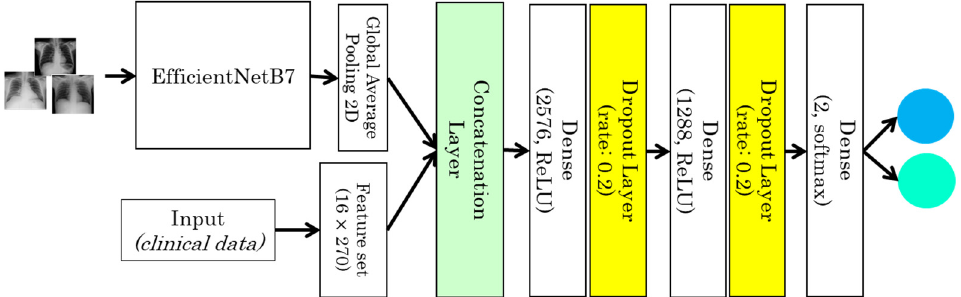
Figure 5. Joint-fusion model for chest X-ray and clinical data (case 3).